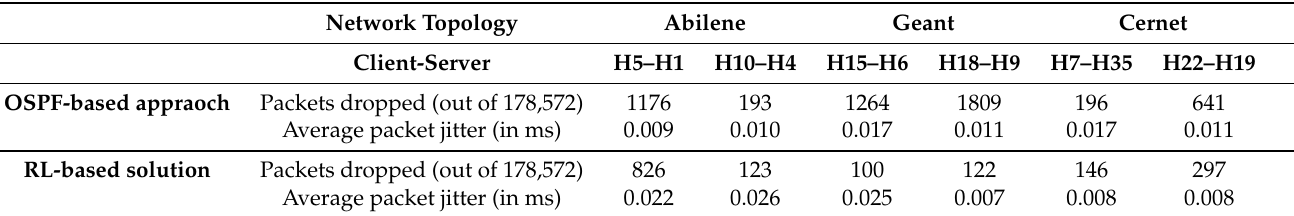
Table 4. The number of packets dropped and average jitter during video transmission for the high background traffic load under three topologies (includes random client-server from each net- work